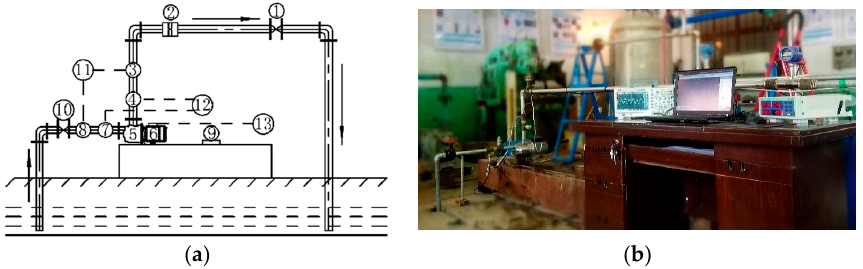
Figure 8. Testing system. ( a ) Schematic diagram of test system structure; ( b ) Test site. 1: Valve at pump outlet; 2: Flowmeter; 3: Pressure sensor at pump outlet; 4: Hydrophone at pump outlet; 5: The model pump; 6: Electric motor; 7: Hydrophone at pump inlet; 8: Pressure sensor at pump inlet; 9: Tachometer; 10: Valve at pump inlet; 11: Computer; 12: Oscilloscopes; 13: Measuring instrument of electric power.